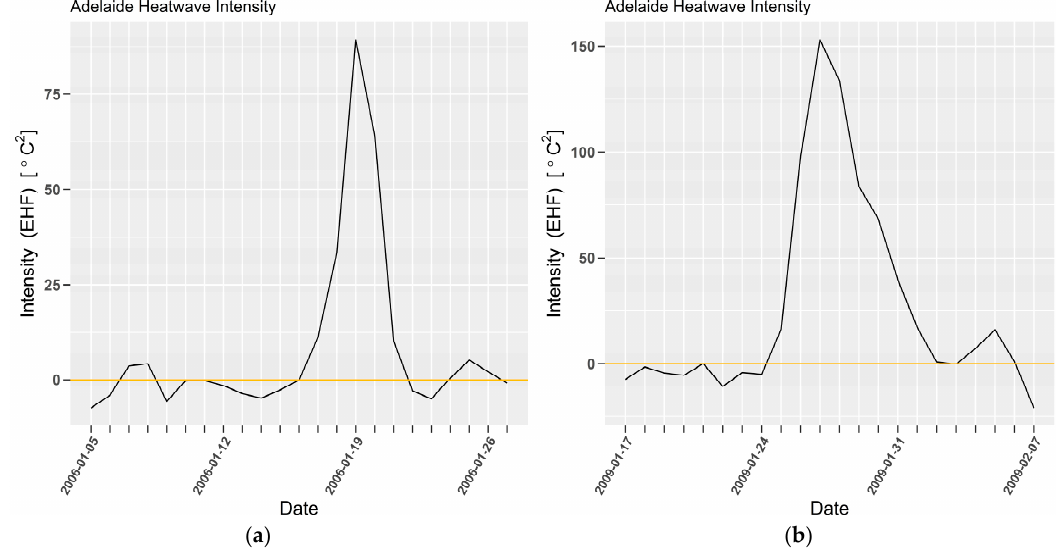
Figure A5. Excess Heat Factor for Adelaide’s 2006 ( a ) and 2009 ( b ) heatwaves, calculated using site data.